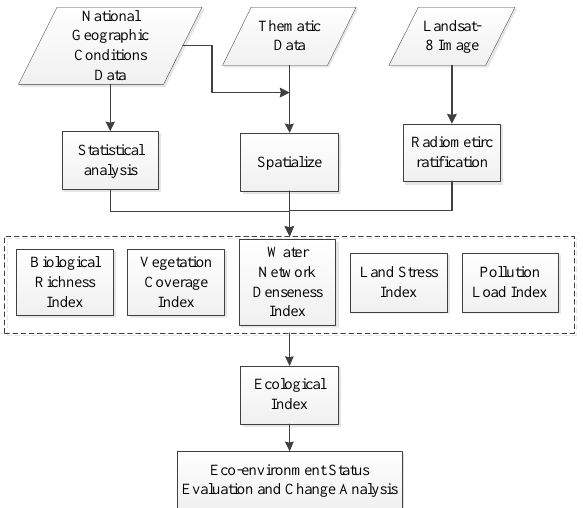
Figure 1. Procedure of eco-environment status